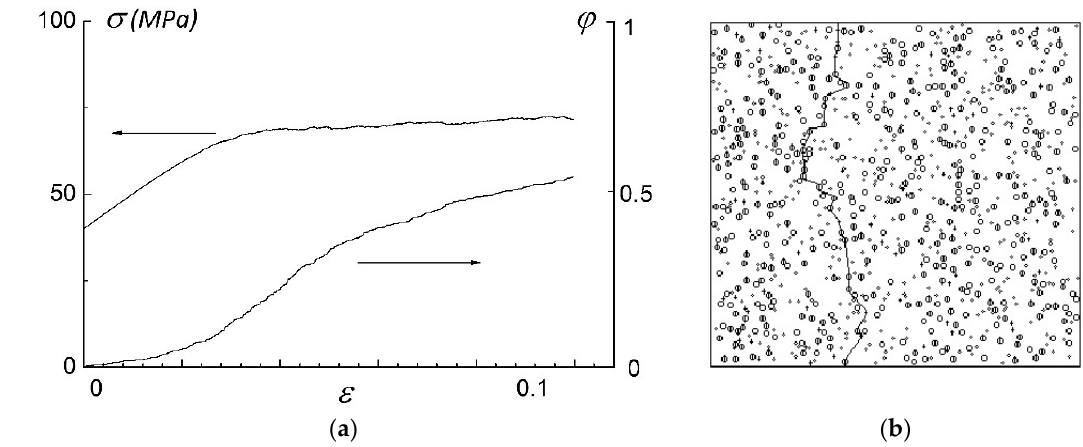
Figure 3. Example of simulation of plastic deformation and damage. ( a ) Deformation curve and strain dependence of the fraction ϕ of cracked particles. ( b ) Specimen face representing both cracked and surviving rigid spheres and the coalescence of cracks by matrix decohesion. m = 8.